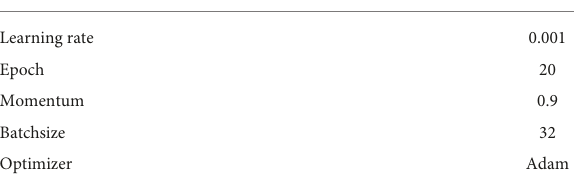
TABLE 4 Hyperparameter settings.